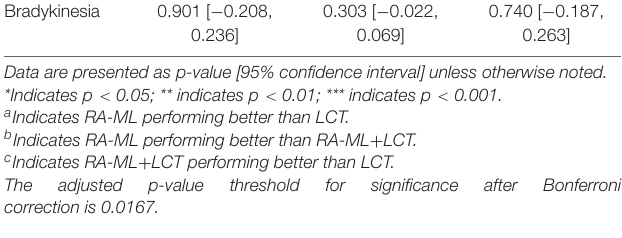
patients with optimal global motor outcome as compared to those with suboptimal efficacy (shown in A and B in Figure 3 ).